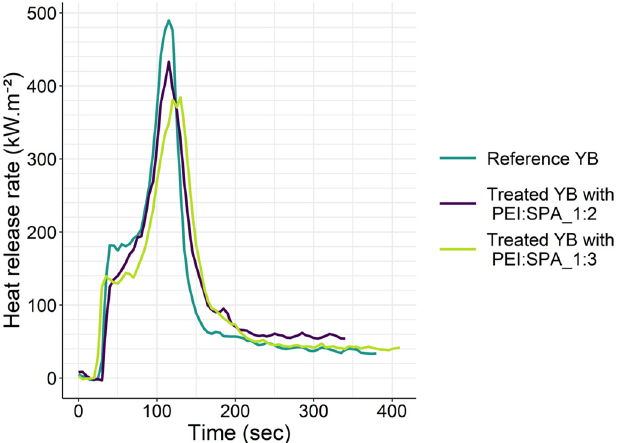
Figure 9. Heat release rate curves of yellow birch depending on the PEI:SPA ratio. Table 4. Cone calorimeter results of yellow birch (virgin and treated with PEC at two ratio). Reference